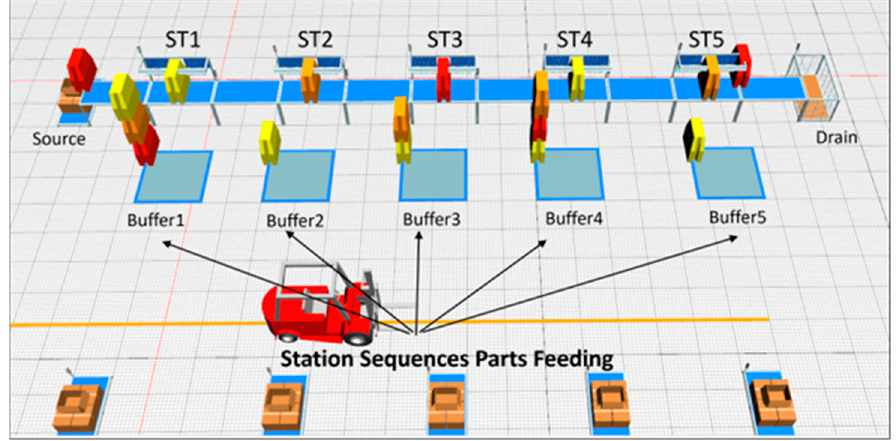
Figure 2. Representation of the modeled assembly system.